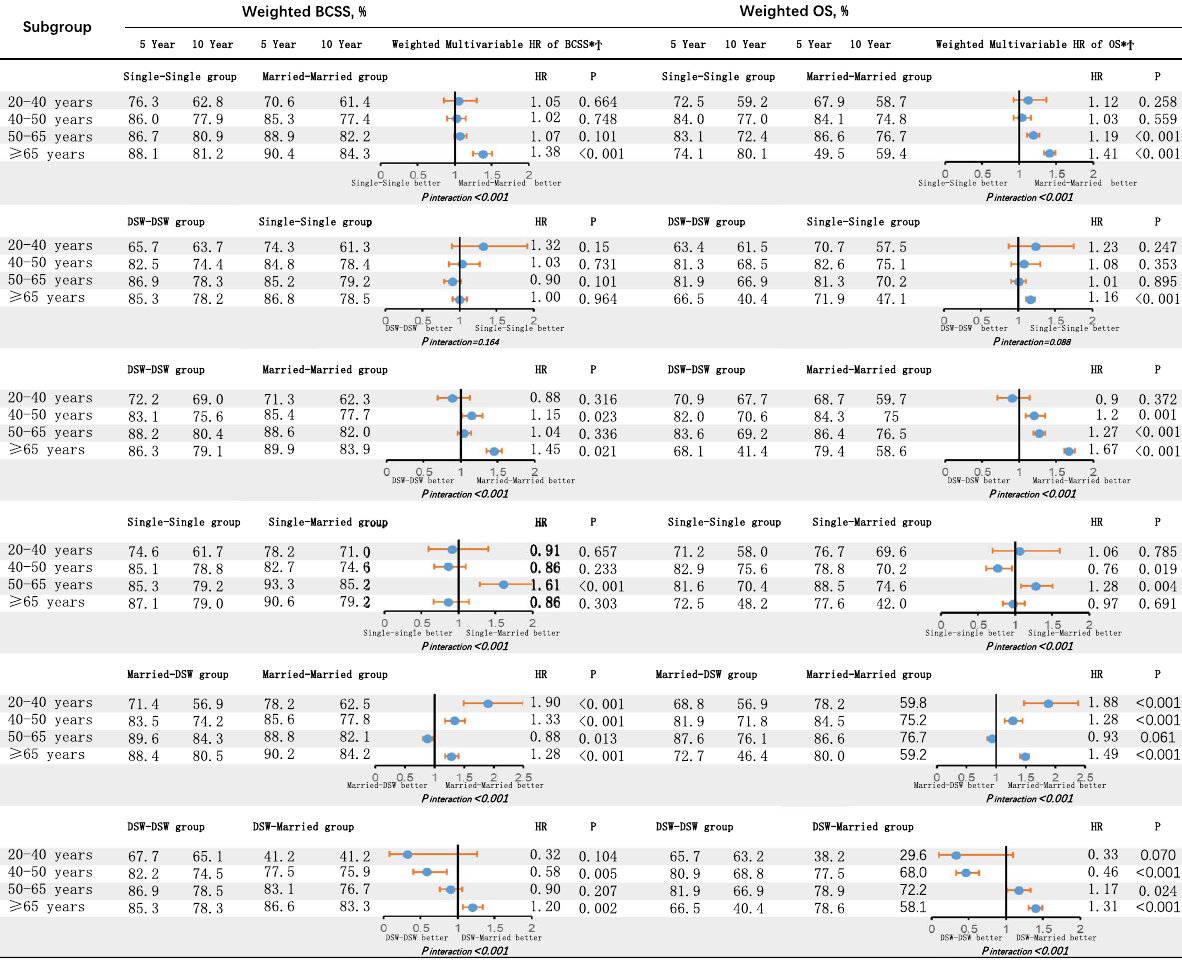
Figure 3. Hazard ratio comparing BCSS and OS according to marital status in different subgroups. (*) Weighted by inverse propensity score. ( Ϯ ) Multivariate analysis adjusted by year of diagnosis, age, race, year of diagnosis, insurance, histology type, nuclear grade, T stage, N stage, M stage, ER status, PR status, surgery, chemotherapy and radiotherapy. BCSS breast cancer-caused special survival, OS overall survival, HR hazard ratio, DSW